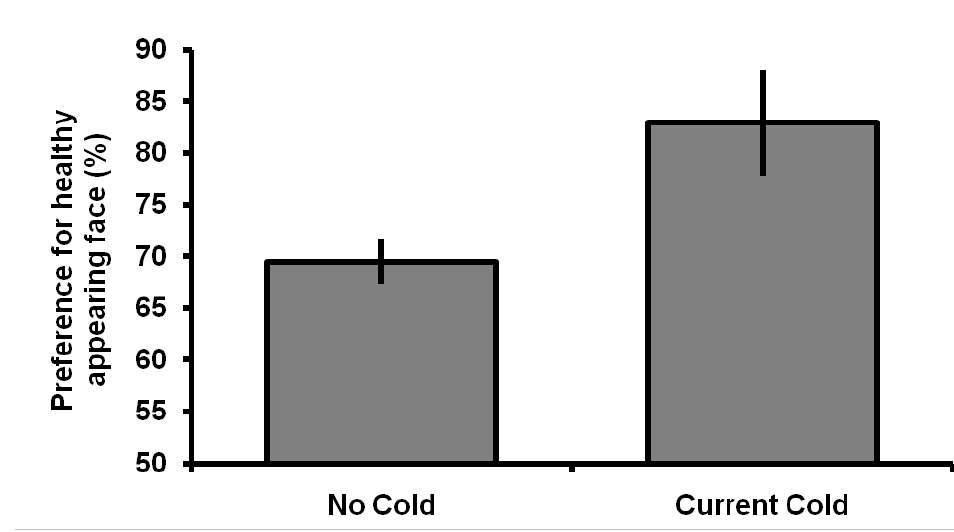
Figure 3 . Preferences for healthy appearance in male faces according to current cold status (±1SEM).